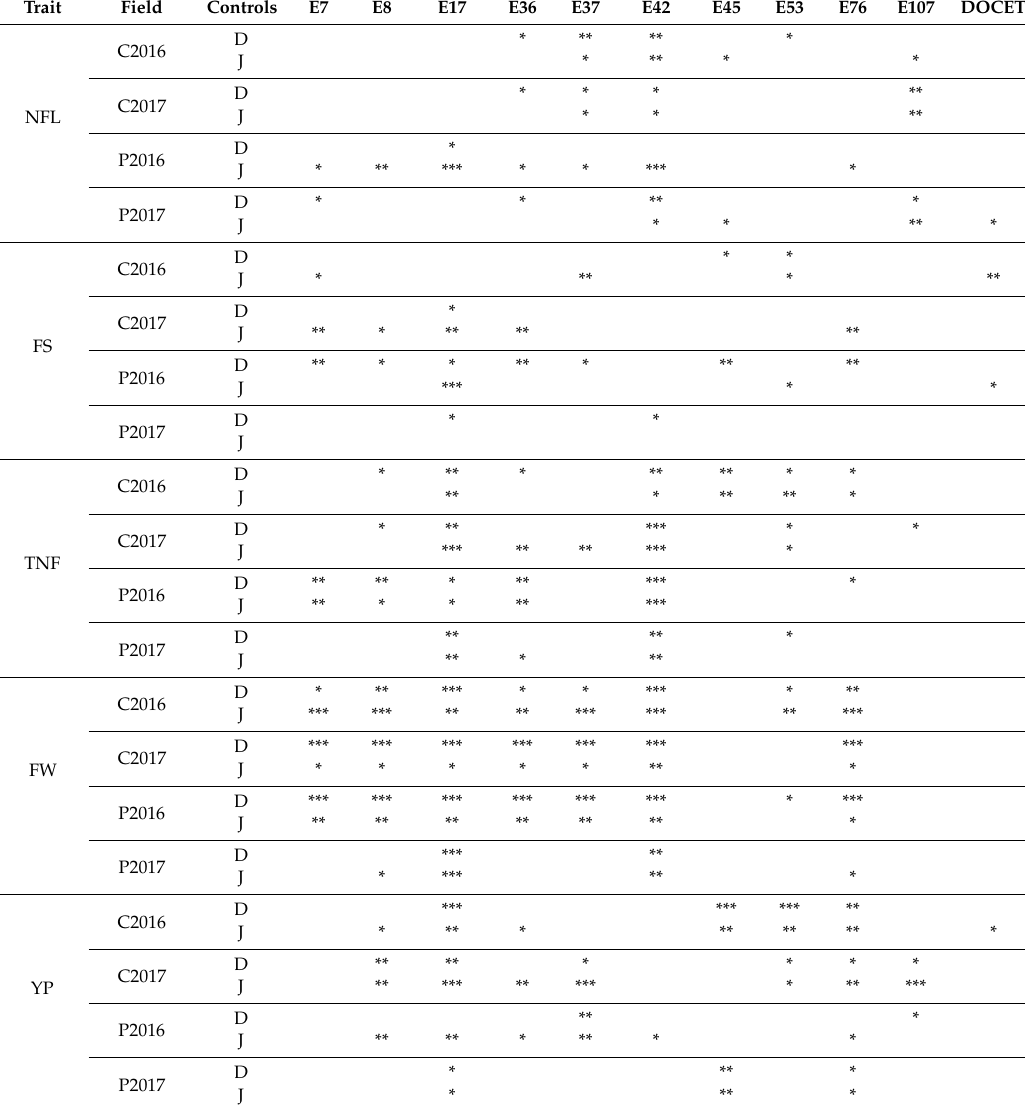
Table 1. Evaluation of significative di ff erences of five phenotypic traits between the landraces (coded E) and the two control hybrids (DOCET and JAG8810) by Student’s t -test (*: p < 0.05, **: p < 0.01, ***: p < 0.001). Red and black asterisks indicate a reduction or an increase of the traits value compared to that of the control genotypes (D = DOCET, J = JAG8810), respectively. (NFL = No. of flowers / inflorescence, FS = Fruit set, TNF = No. of fruit / plant, FW = Fruit weight, YP = Yield / plant. C2016 = Campania field in the year 2016, C2017 = Campania field in the year 2017, P2016 = Puglia field in the year 2016, P2017 = Puglia field in the year